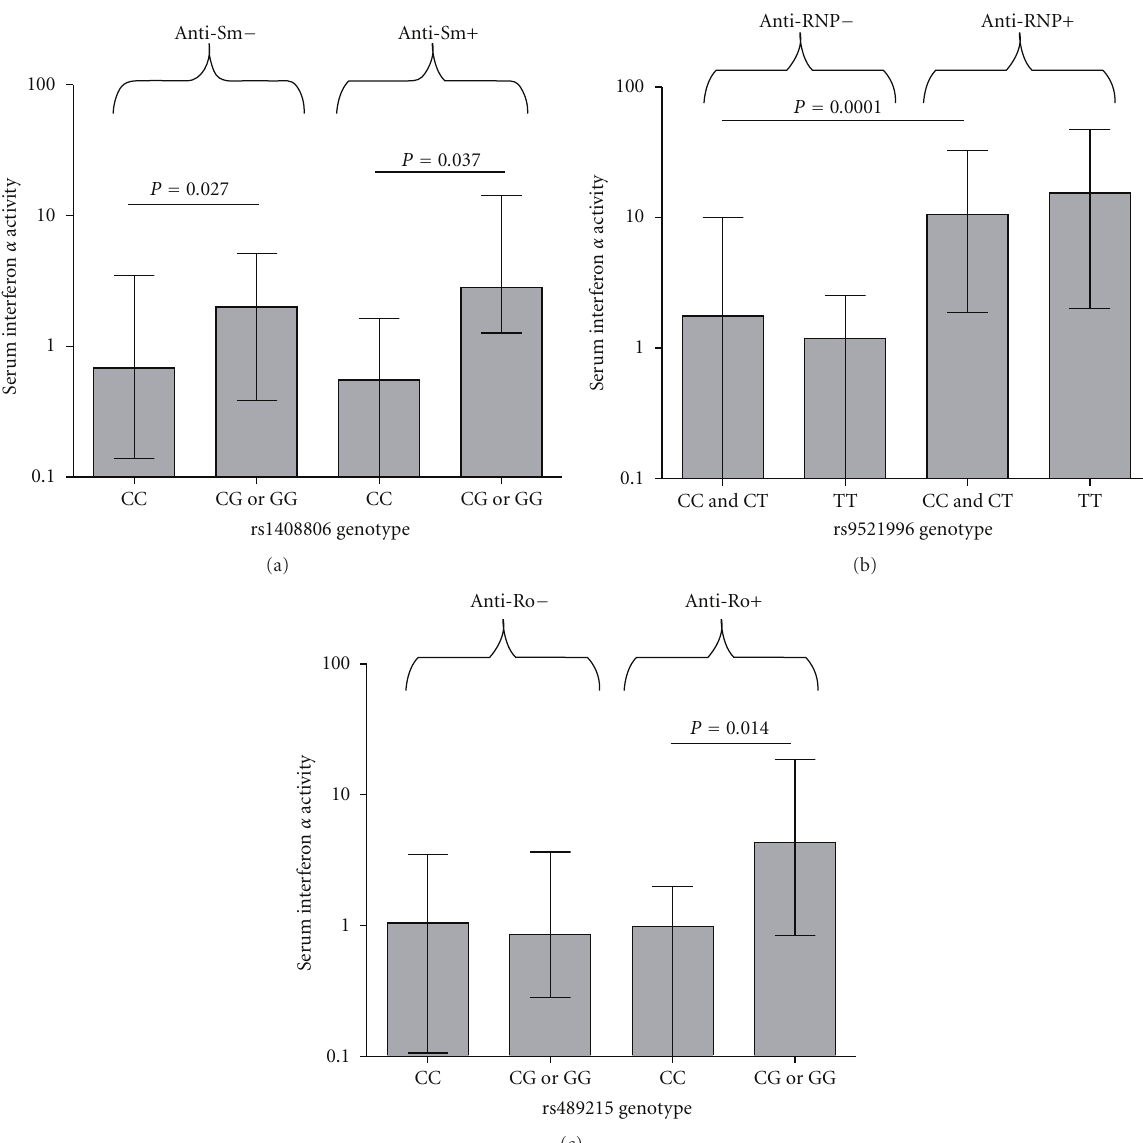
Figure 4: Serum IFN- α activity in SLE patients stratified by SNP genotype and the autoantibody associated with that particular SNP. Minor allele homozygotes are combined with heterozygotes on the graph. Bars show the median error bars show the interquartile range. P value by Mann-Whitney U test.